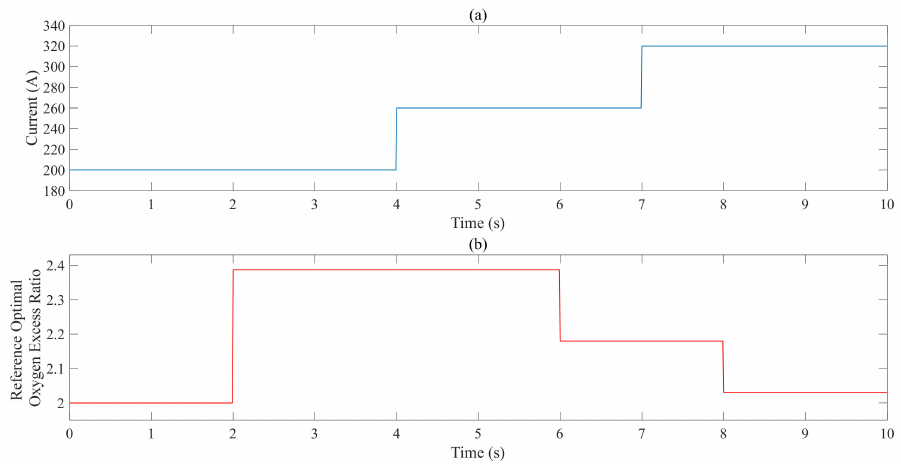
Figure 5. The simulation condition: ( a ) Load current change condition; ( b ) Reference optimal oxygen excess ratio.